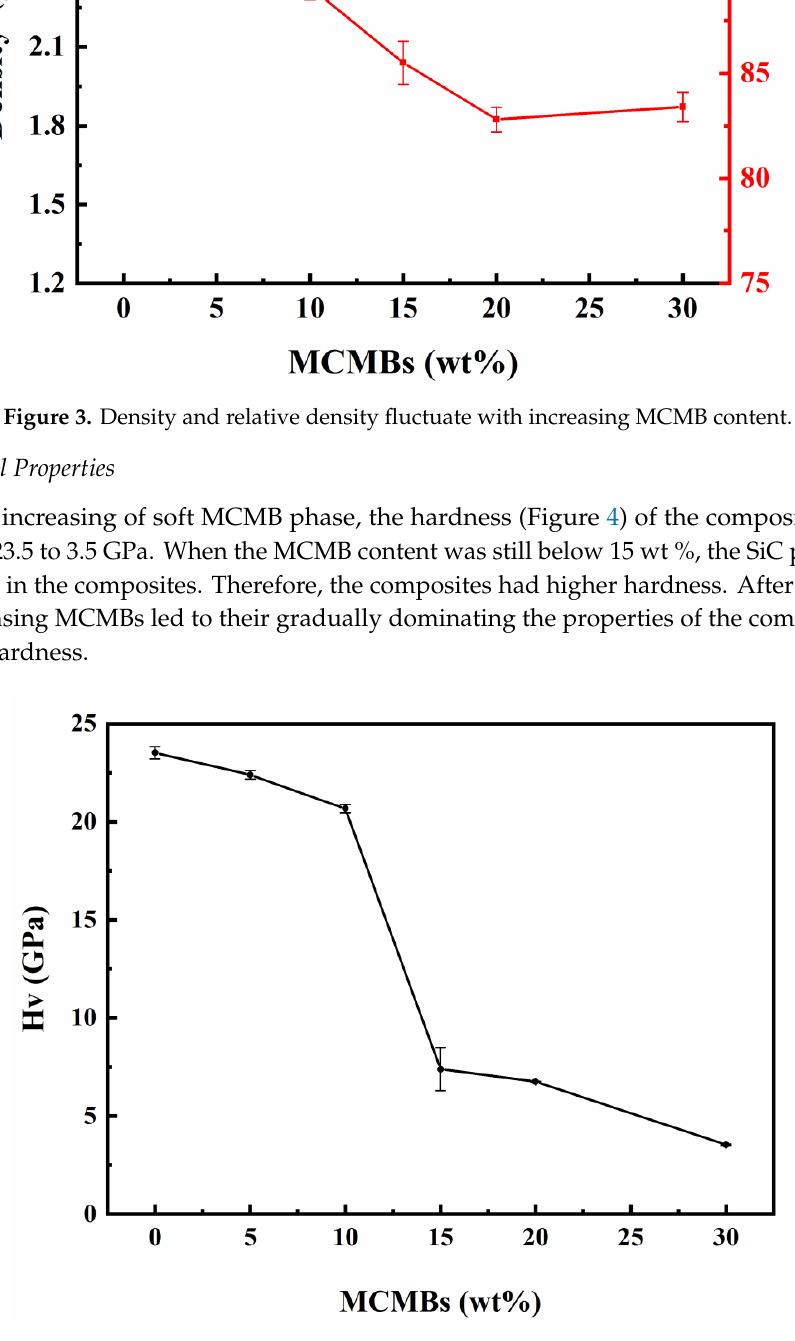
Figure 5. Fracture toughness and porosity fluctuate with MCMB content. As shown in Figure 5, the fracture toughness of the samples fluctuated with the increase in MCMB content. First, the curve increased, and the maximum value was obtained with M-10 samples.